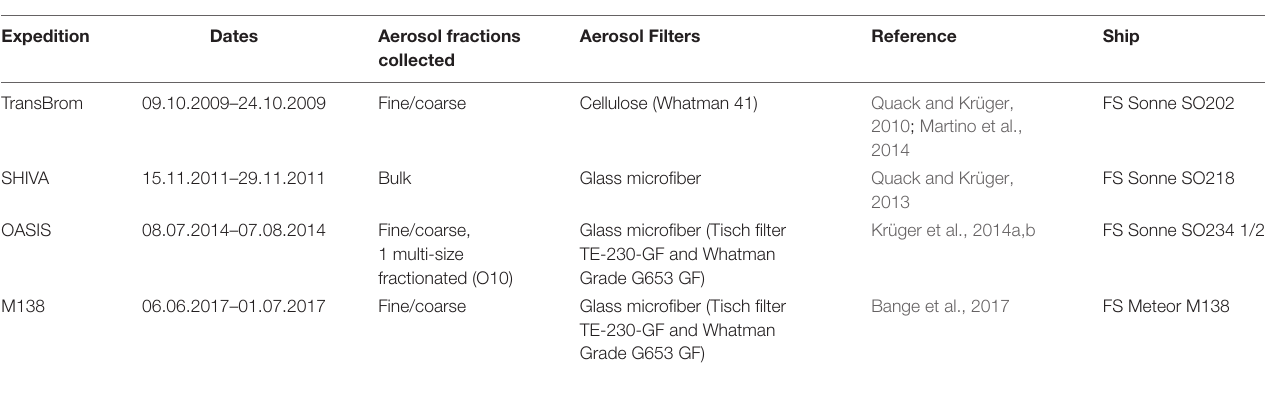
TABLE 1 | Overview of sea-going expeditions presented in current work.